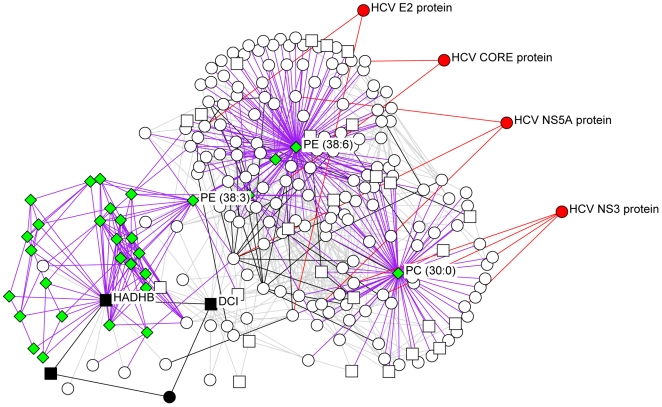
The integrated network surrounding several key bottlenecks identified by computational modeling efforts.The neighbors of bottlenecks in the integrated network (DCI, HADHB, PC 30∶0, PE 38∶3, and PE 38∶6) are shown. Relationships between the proteins and lipid species are grey for proteomics correlation, purple for lipidomics-proteomics correlation, black for protein-protein interactions and red for IMAP relationships. Lipid species are indicated as green diamonds, HCV proteins are red, mitochondrial proteins are squares, and proteins involved in fatty acid β-oxidation are in black.